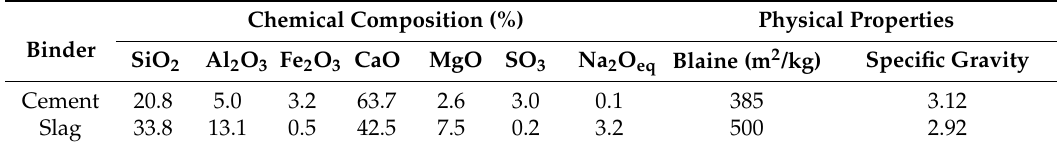
Table 1. Chemical and physical properties of ordinary Portland cement and slag.